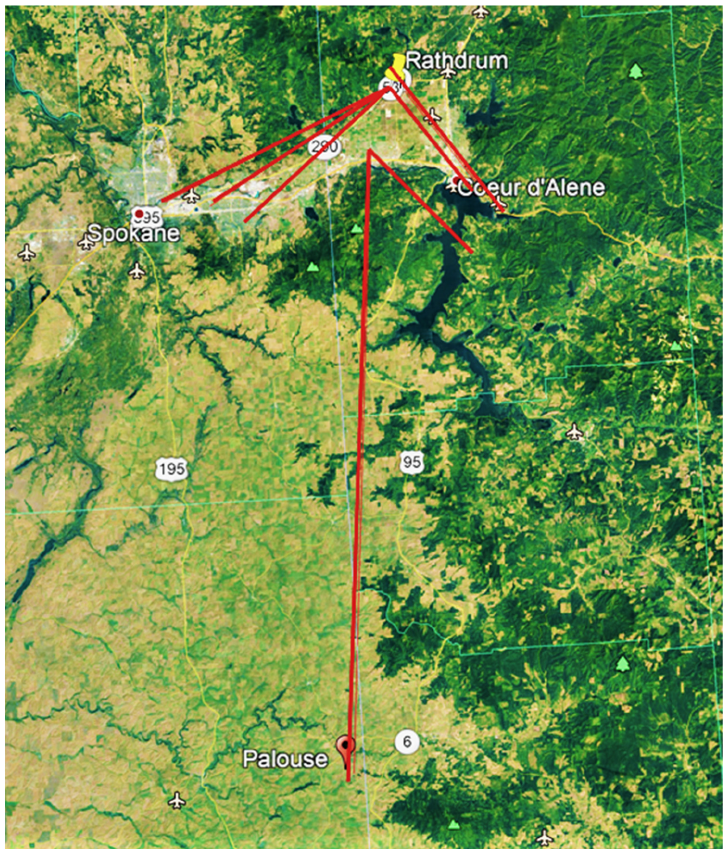
Figure 4. Release–recovery lines (N to S) for captive-reared tagged monarchs released in Idaho during 2017–2019.